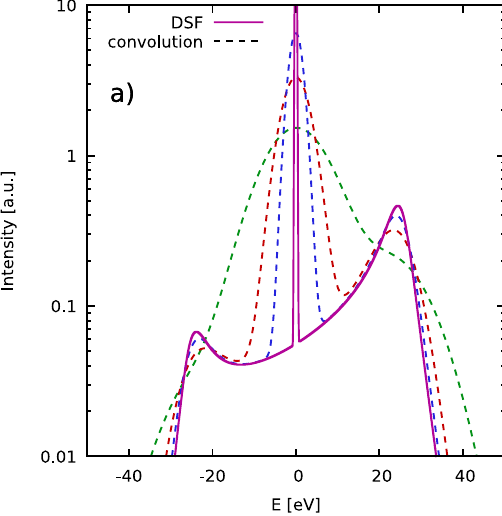
Fig. 1 | Demonstration of the temperature diagnostics from an XRTS signal. Panel a shows synthetic results for the dynamic structure factor (solid purple) in atomic units [a.u.] of a uniform electron gas 29 (with a narrow Gaussian ion feature around E = 0) at the metallic density of r s = r = a B =2 (with r being the average electronic separation) computed for the electronic Fermi tempera- ture T = 12.53eV, and for half the Fermi wave number 40 q = 0.5 q F =0.91 Å − 1 . The